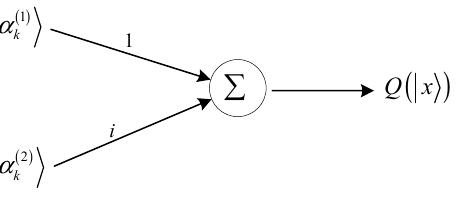
Figure 9. The output .